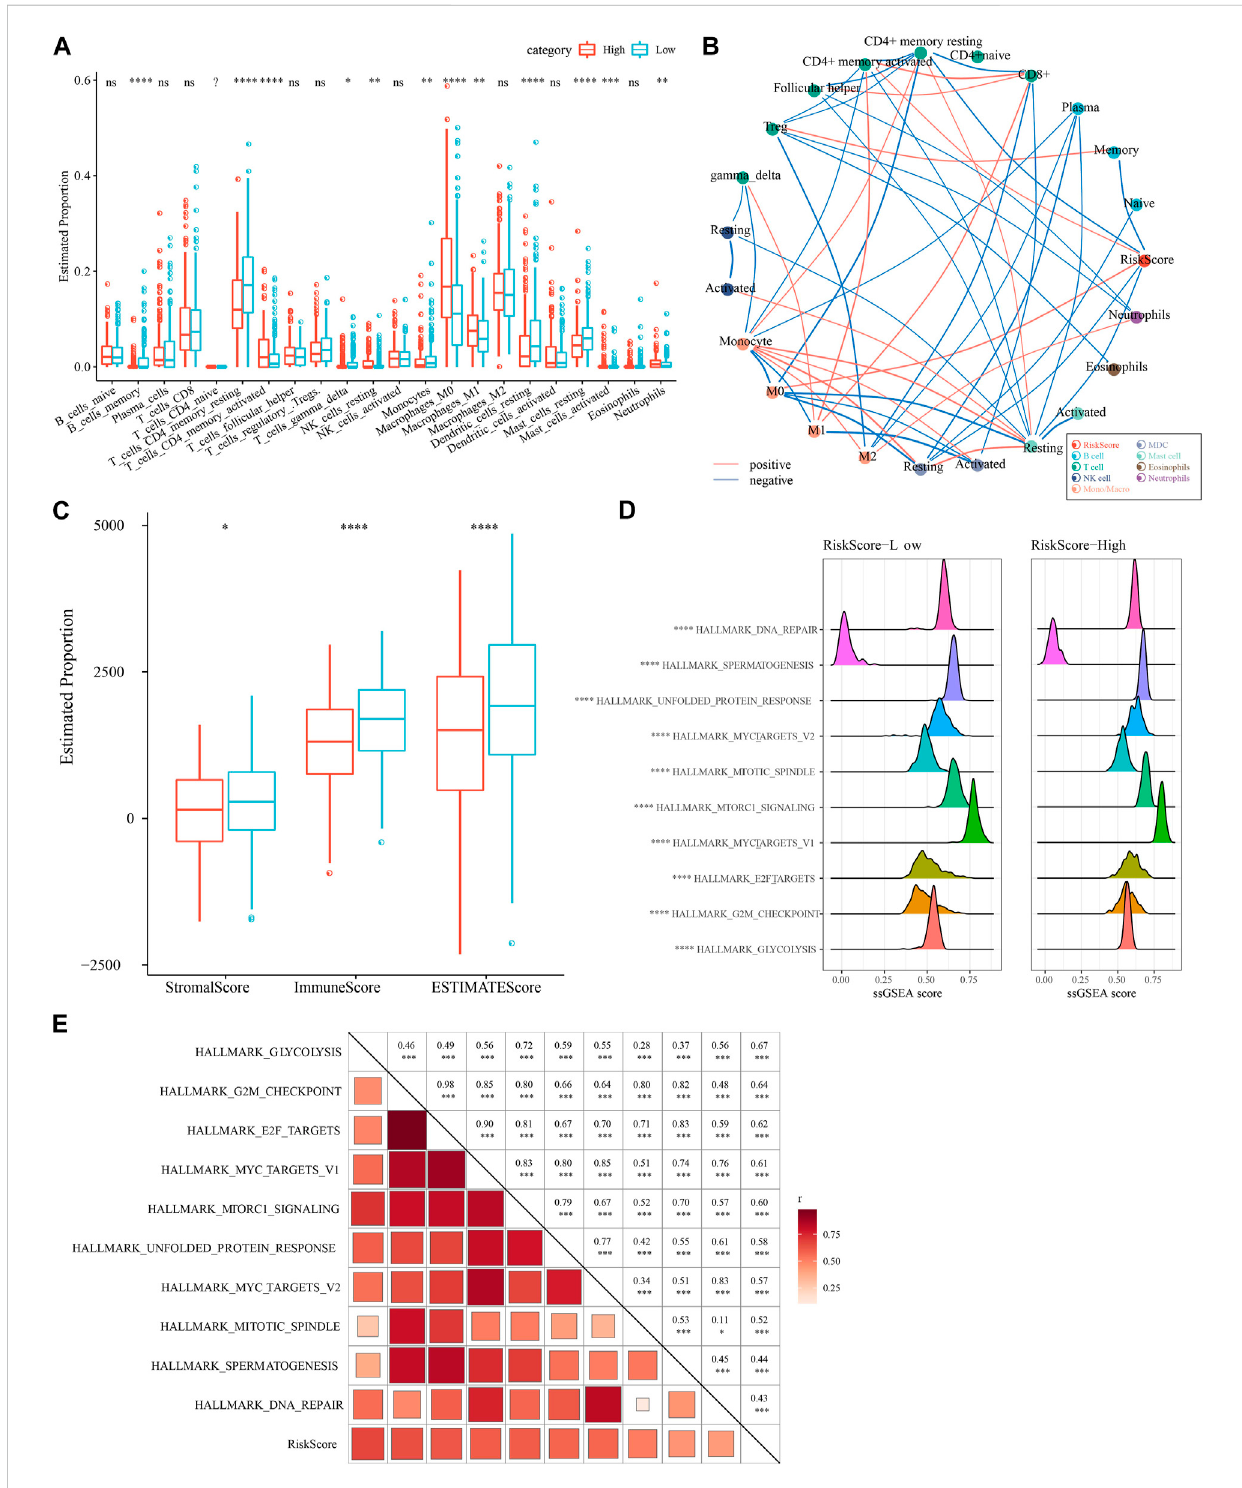
FIGURE 9 Immune in fi ltration/pathway characteristics between RiskScore subgroups. (A) Proportion of immune cell components in the TCGA cohort. (B) Correlation analysis of 22 immune cell components in the TCGA cohort with the RiskScore. (C) Proportion of immune cell components in the TCGA cohort calculated by ESTIMATE software. (D) The top 10 pathways with the most signi fi cant differences between high- and low-groups. (E) Results of correlation analysis between the RiskScore and KEGG pathways with correlation greater than